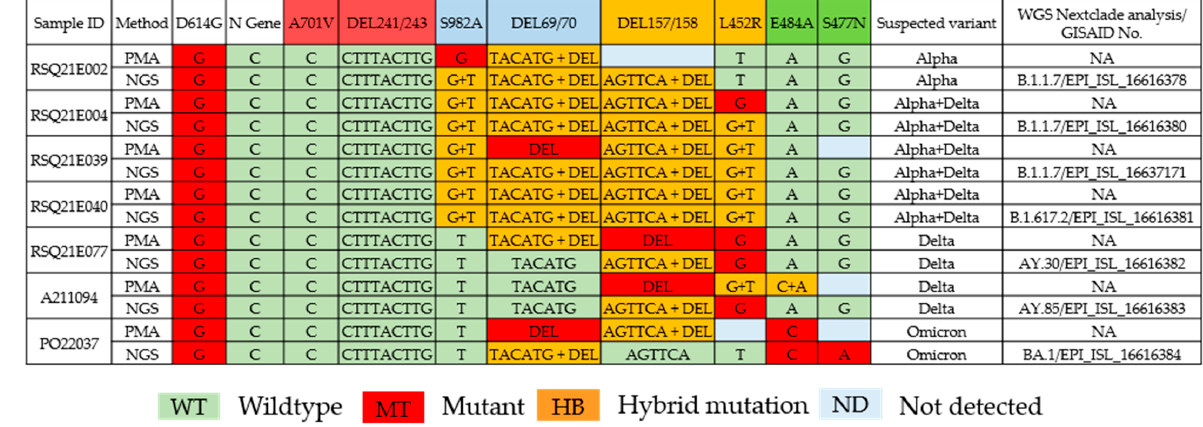
Figure 3. Comparison of point mutations at eight specific sites of the spike gene for differentiating SARS-CoV-2 variants detected by PMA and NGS in each wastewater specimen: Alpha (S982A, DEL69/70), Beta (DEL241/243, A701V), Delta (DEL157/158, L452R), and Omicron (E484A, S477N), and two control genes (N and D614G). The suspected variant columns indicate a possible combination of SARS-CoV-2 variants in each specimen. The SARS-CoV-2 lineage identified by Nextclade and the accession number of each NGS data point are shown in the last column.